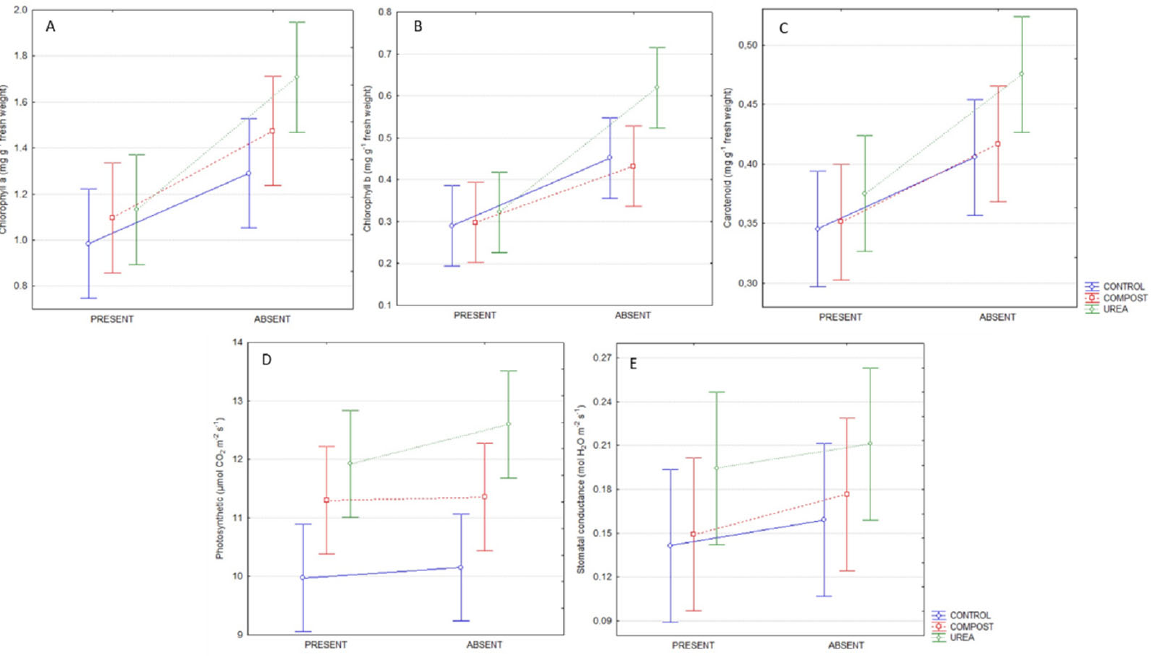
Figure 5. Chlorophyll a ( A ), chlorophyll b ( B ), carotenoids ( C ), photosynthesis ( D ) and conductance ( E ) concentrations in leaves from peach trees cultivated in pots with urea and organic compound application, Paspalum notatum presence and absence. Two-way ANOVA. Tukey test at 5% probability. The values presented are averages of three replicates per treatment and the vertical bar represents the standard